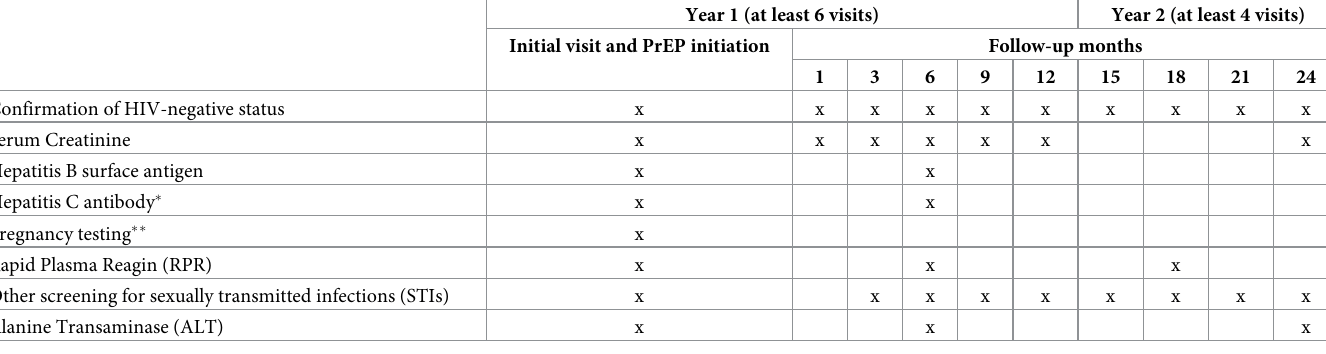
Table 1. PrEP clinical activities adapted from the Zambian PrEP implementation framework